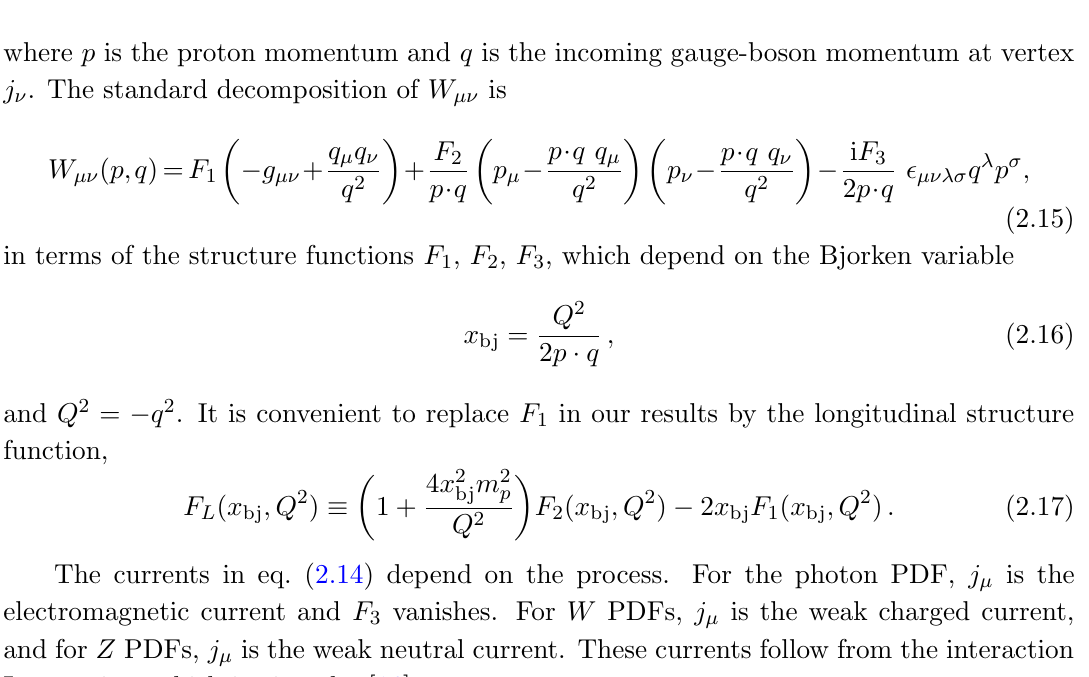
Figure 2 . Radiative corrections to W boson PDFs. The right diagram does not allow a simple factorization in terms of structure functions, as it involves a three-point correlator in the